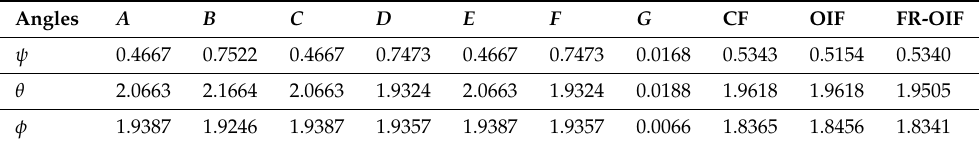
Table 3. RMSE comparison for the estimation of the orientation in Euler angles.